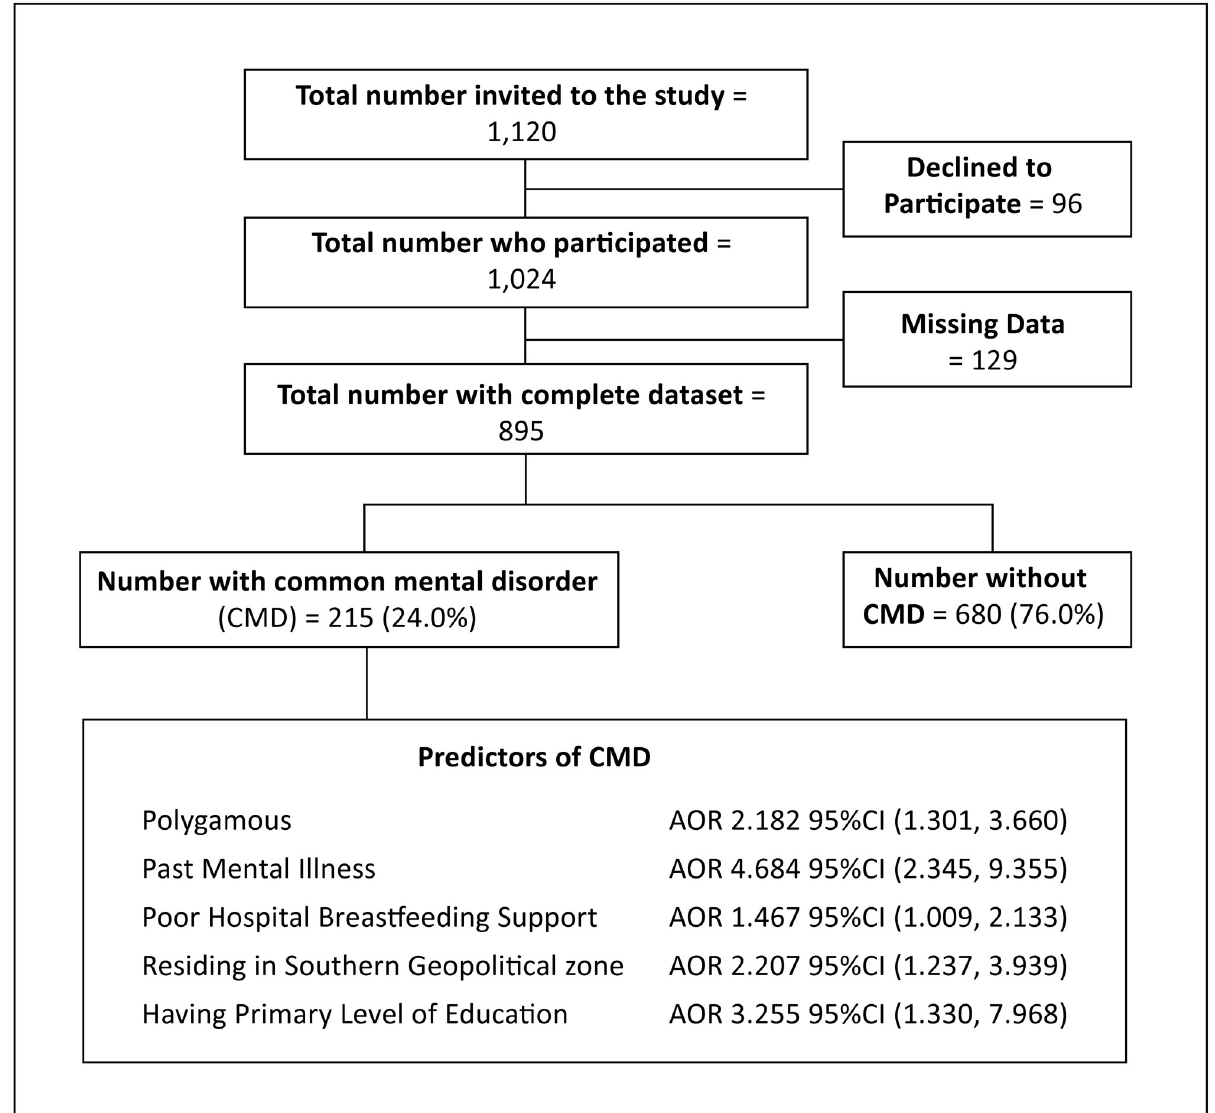
Fig 2. Participants flow chart study on common mental disorders among breastfeeding mothers in Nigerian tertiary hospital nurseries (The flow chart describes the participants’ enrollment and the predictors of common mental disorders among breastfeeding mothers whose babies were admitted to tertiary